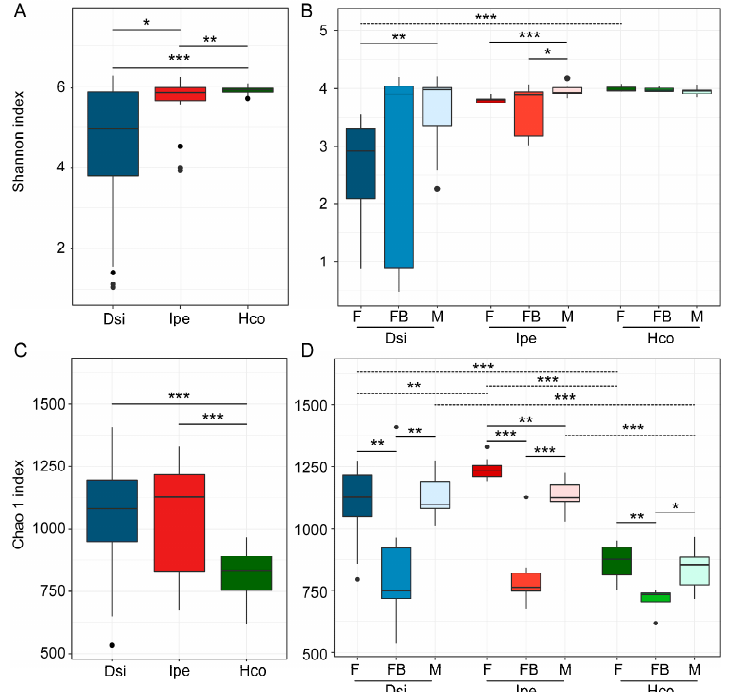
Figure 1. Microbial diversity and richness in samples. ( A , B ) Shannon diversity indices at the OTU level for all tick species ( A ) or for each group within a species ( B ). ( C , D ) Chao1 indices at the OTU level for all tick species ( C ) or for each group within a species ( D ). The Wilcoxon rank test was used to determine significance (* p < 0.05, ** p < 0.01, *** p < 0.001) within species (full line) or groups (dotted line). Notes: F, female; FB, full of blood (engorged); M, male; Dsi, Dermacentor silvarum ; Ipe, Ixodes spersulcatus ; Hco, Haemaphysalis concinna .